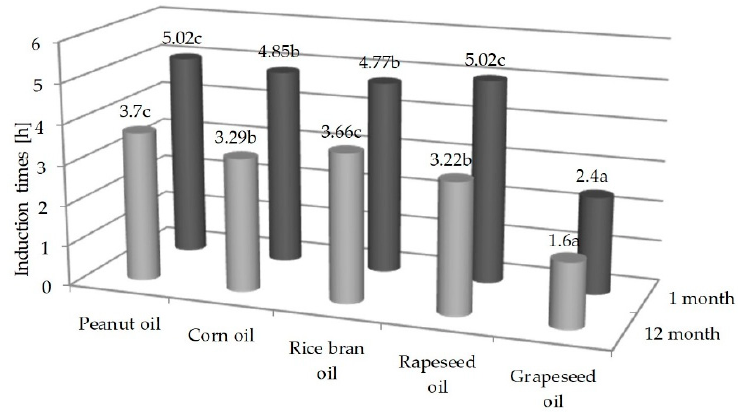
Figure 4. Induction time of the selected oils determined in the Rancimat test in the 1st and 12th months of storage. Different small letters indicate statistically significant differences at the level p < 0.05 between oils in month.